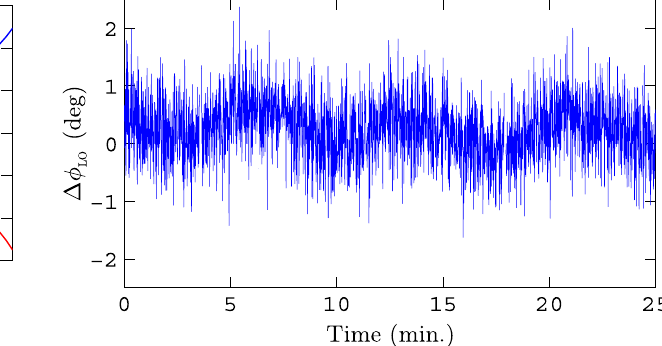
=V Σ vs Q FIG. 13. Illustrative measured LO phase (degrees of 714 MHz) vs beam extraction time.